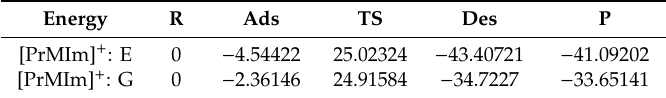
Figure 12. Step-by-step reaction process, in which the reactants C 2 H 2 and HCl are adsorbed and react near the active N sites of [PrMIm]Cl. Here [PrMIm] + serves as the catalyst. The red and blue lines represent the change in energy E and in the Gibbs free energy G , respectively. Table 3. Energy levels of the reaction steps shown in Figure 12 (kcal/mol).